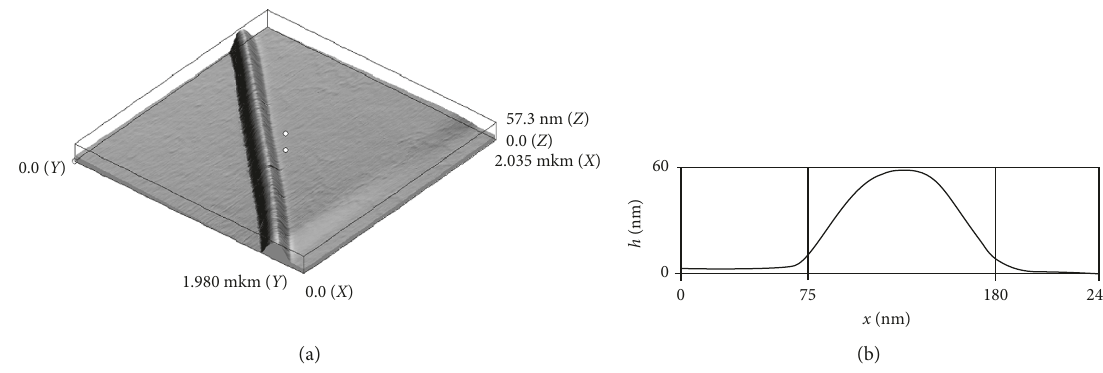
Figure 3: AFM 3D image (a) and profile (b) of the IZO